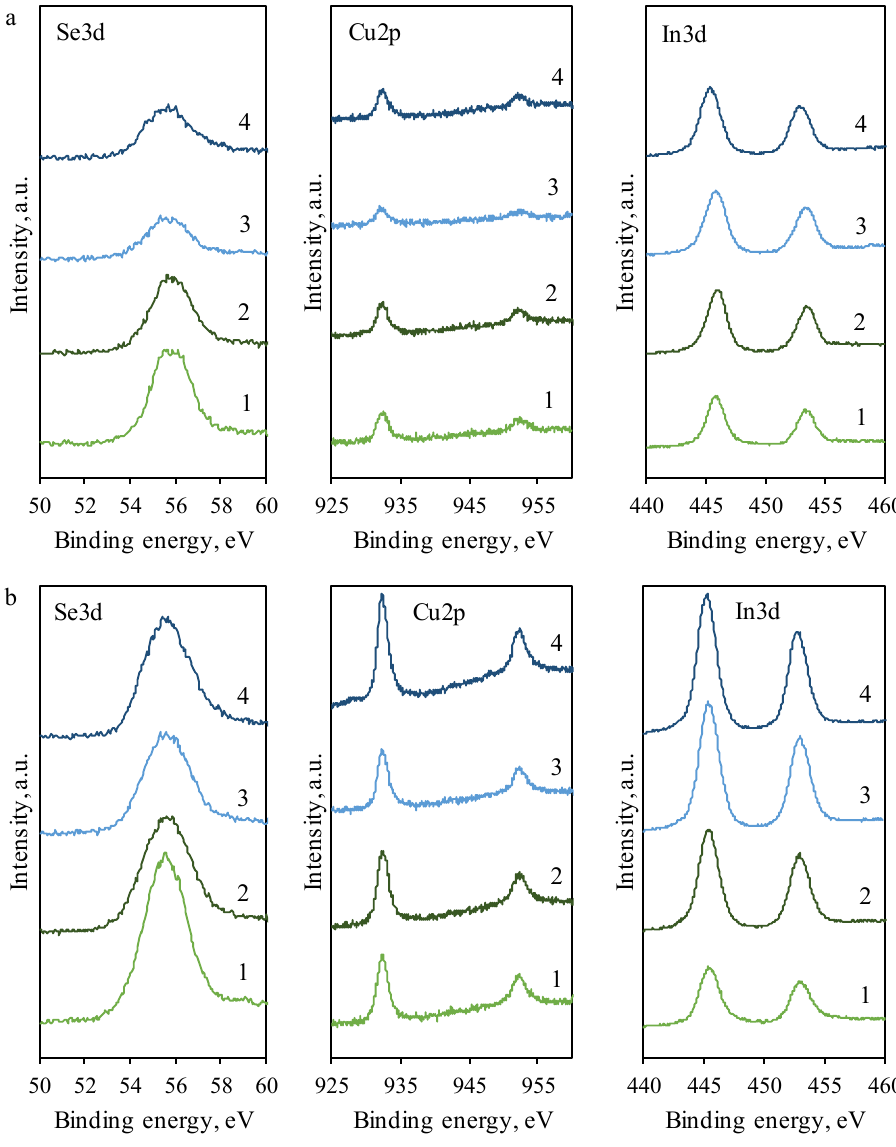
Figure 3. XPS spectra of In-incorporated Cu x Se non-etched ( a ) and etched ( b ) films. Treatment with copper(II/I) ion solution: 1—10 min at 40 °C; 2—20 min at 40 °C; 3—5 min at 60 °C; and 4—10 min at 60 °C.